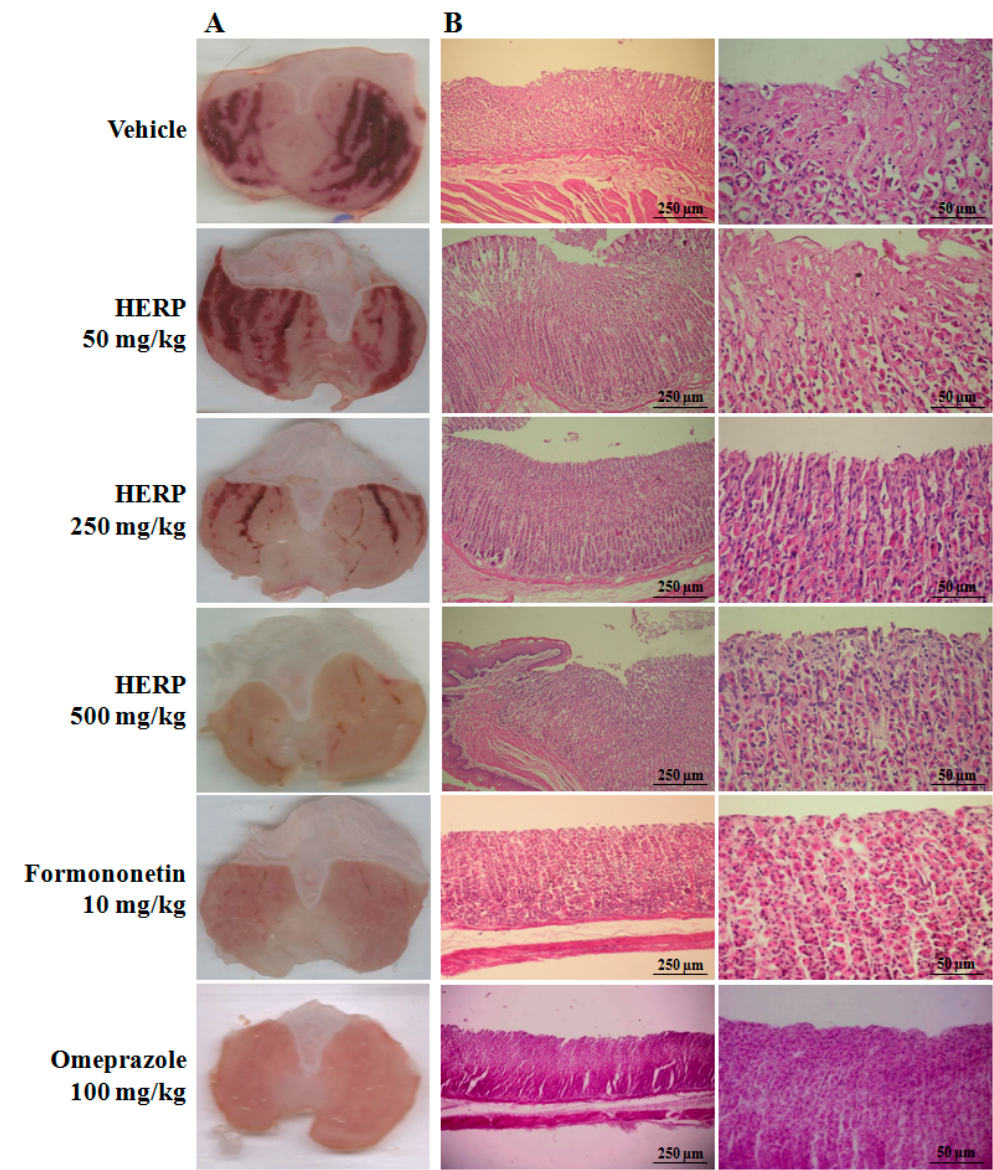
Figure 2. ( A ) Macroscopic effects of HERP, formononetin, and omeprazole in ethanol-induced gastric ulcers; ( B ) hematoxylin/eosin-stained histological sections of gastric mucosa specimens from ethanol treated rats; representative photomicrographs were generated from the same areas and were quantified (Table 1).